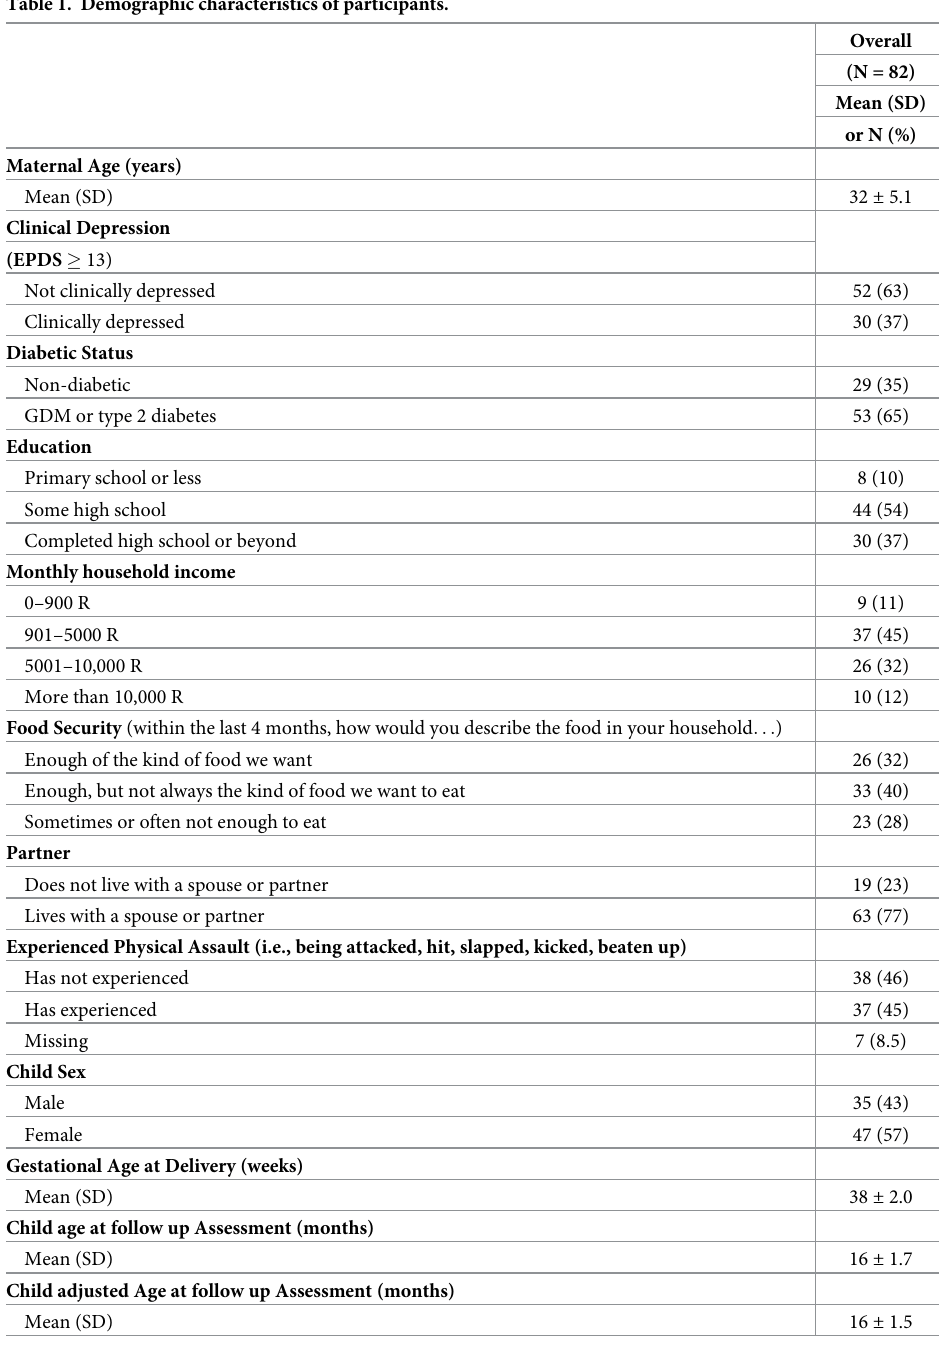
Table 1. Demographic characteristics of